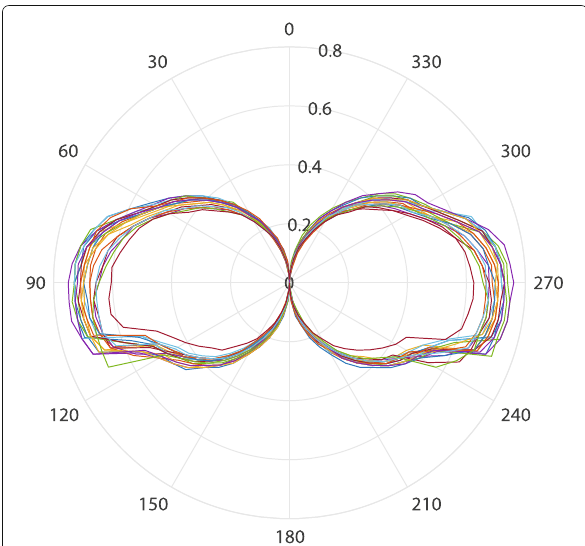
Fig. 3 ITD of the 21 participants measured for the exploratory perceptual test. Radial units are in ms